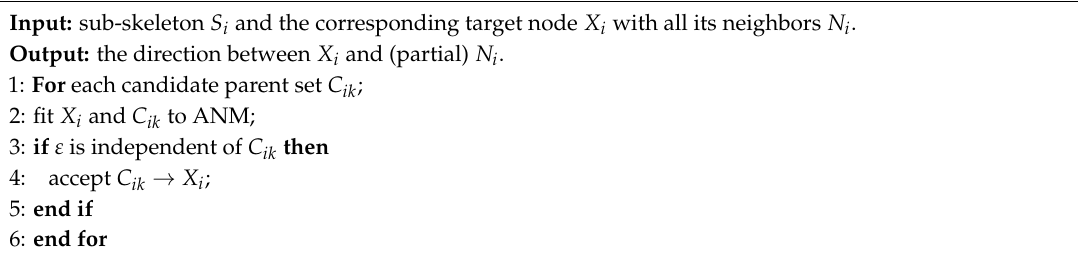
Algorithm 2. Learning causal direction from a